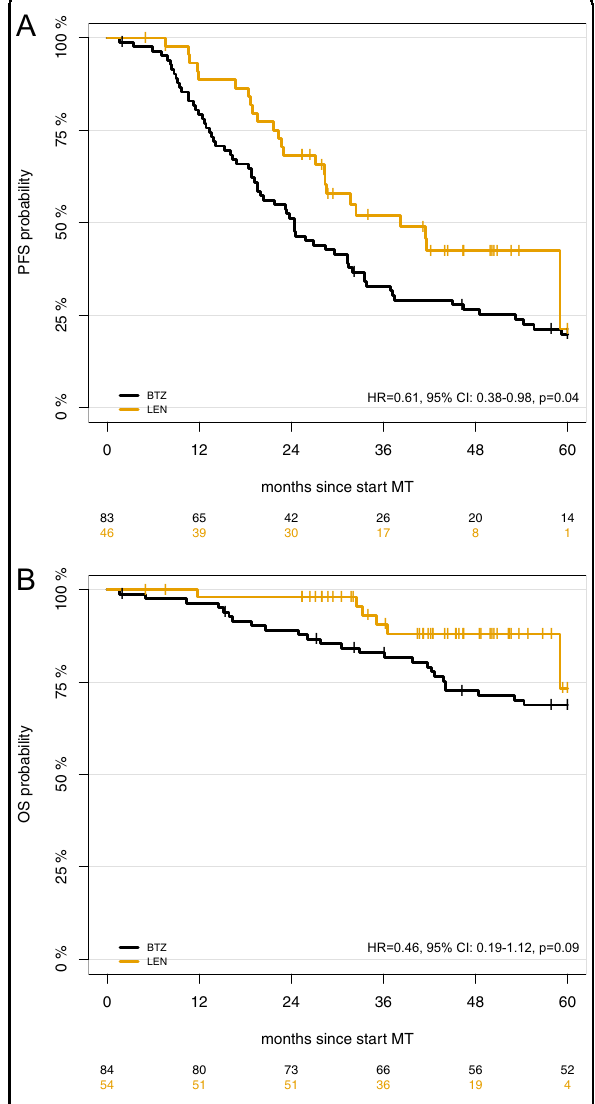
Fig. 4 Progression-free (PFS) and overall survival (OS) in patients receiving tandem autologous stem cell transplants (ASCT) for <nCR after fi rst ASCT. Kaplan – Meier curves are shown for ( a ) PFS and ( b ) OS. LEN lenalidomide, BTZ bortezomib.